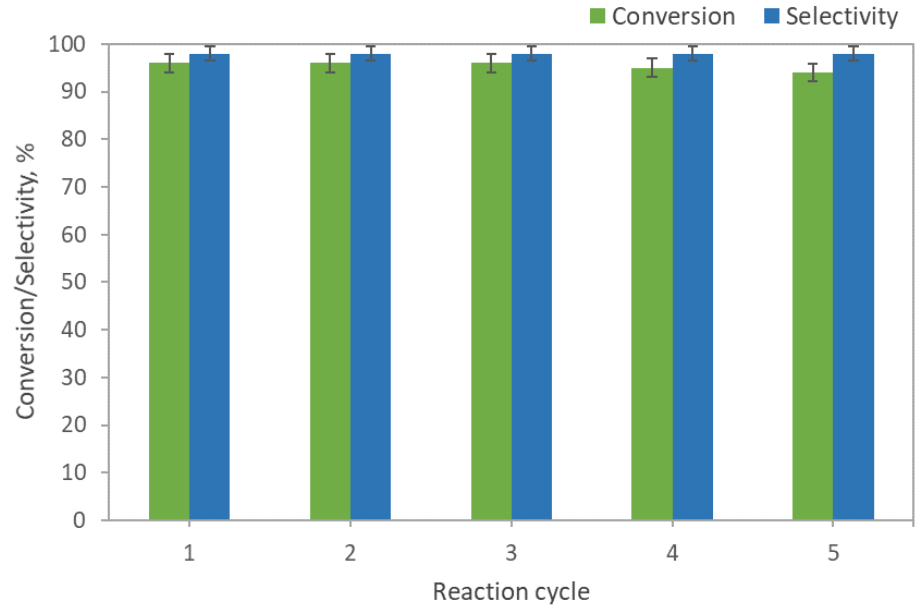
Figure 3. Catalyst recycling tests. Reaction conditions: IBA:FA molar ratio 1.2:1; 40 wt.% K 2 CO 3; PEG 600-PS, 0.5 mol%; 600 rpm; 40 °C, 2 h. Each experiment was performed three times.